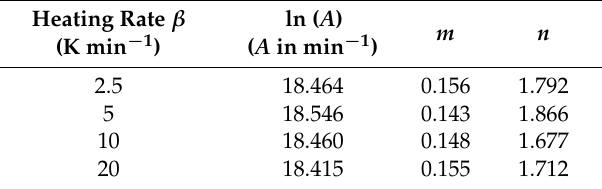
Table 5. Calculated kinetic parameters for autocatalytic SB( m , n ) model by using a non-linear curve fitting, corresponding to the crosslinking of a partially bio-based epoxy resin for different heating rates.